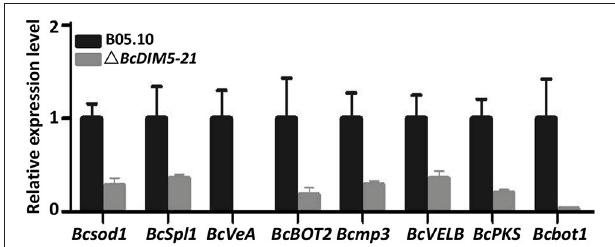
FIGURE 4 | Expression of the genes associated with pathogenesis in wild-type B05.10 strain and BcDIM5 knockout ∆ BcDIM5-21 strains. Botrytis cinerea Bcsod1 (BC1G_00558), BcSpl1 (BC1G_02163), BcVeA (BC1G_02976), BcBOT2 (BC1G_06357), Bcmp3 (BC1G_07144), BcVELB